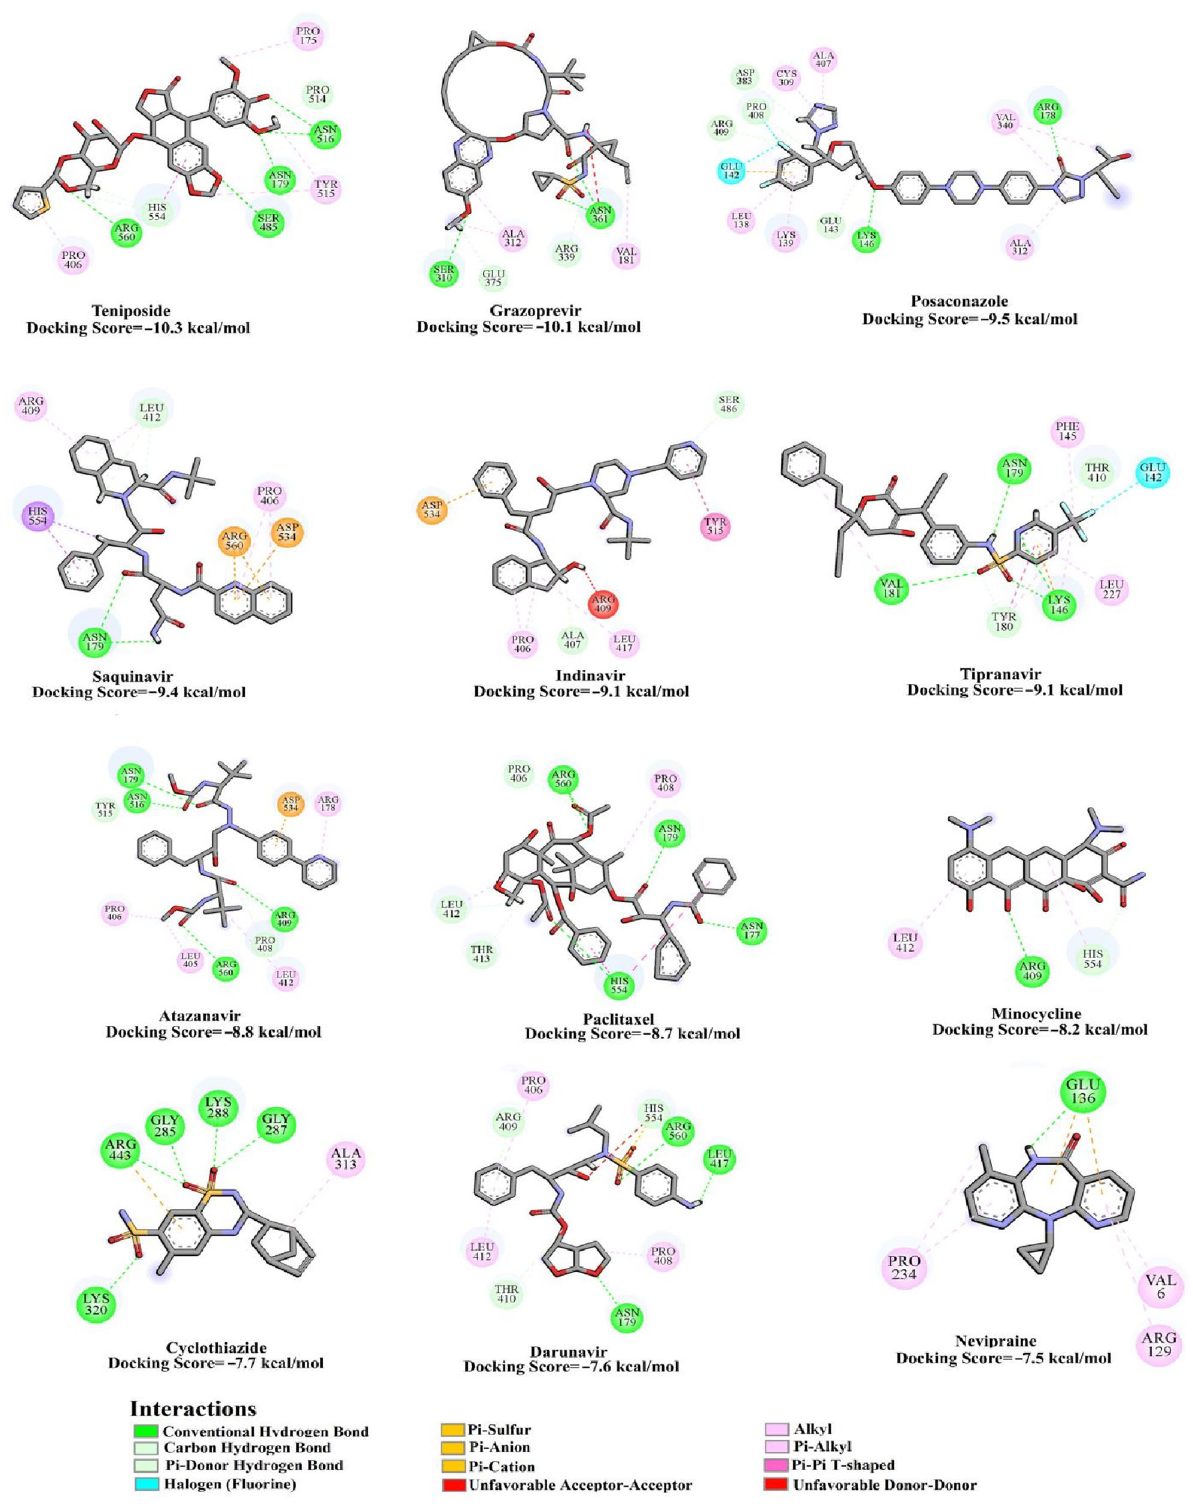
Figure 3. 2D representations of the predicted binding modes and scores of the investigated twelve drugs inside the active site of the SARS-CoV-2